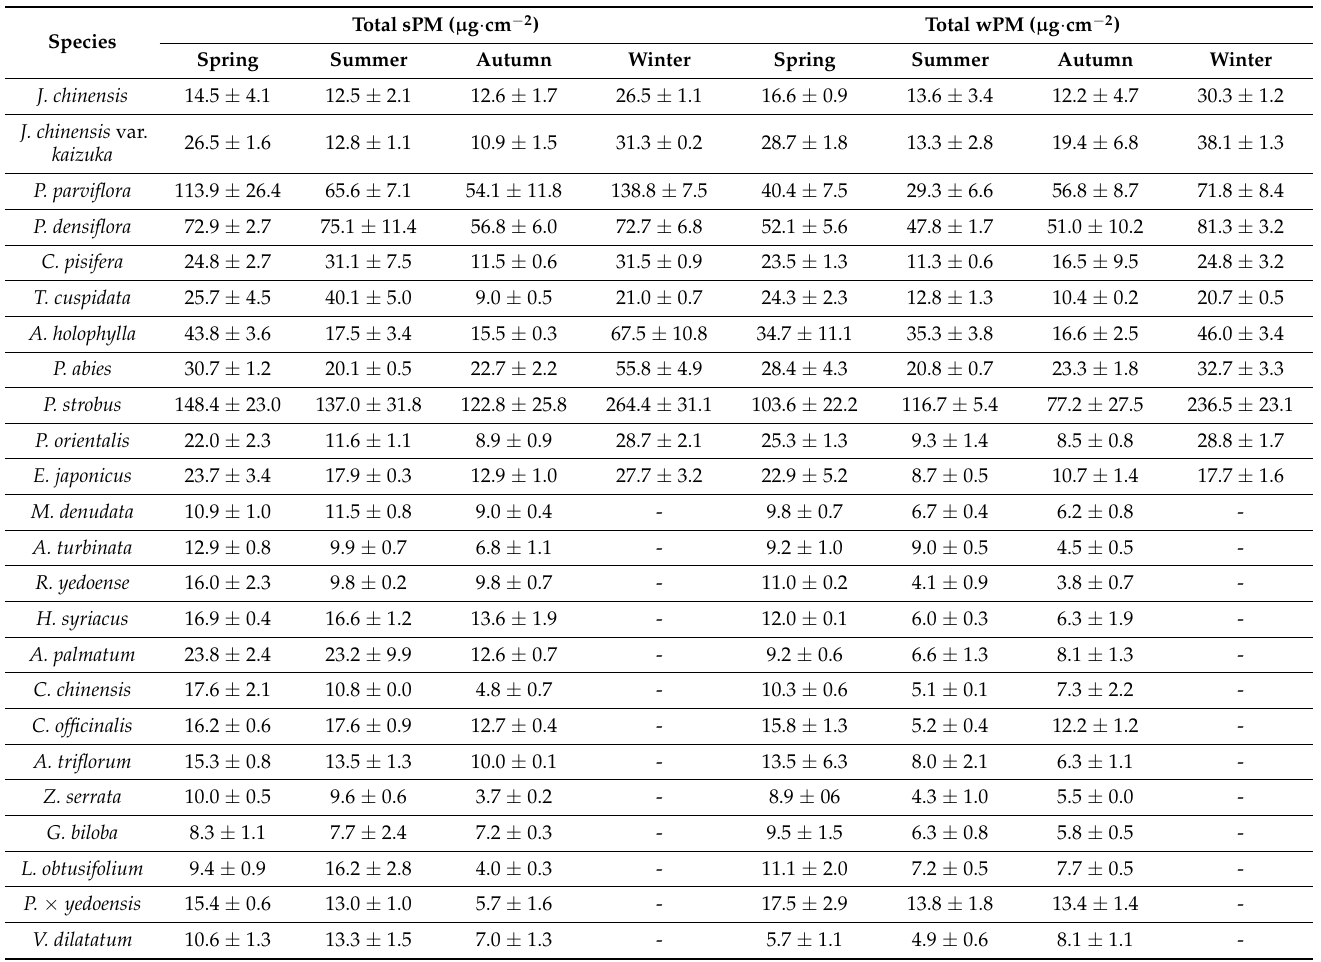
Table 2. The total PM accumulation on the leaf surface and the wax layer of 24 plant species in four seasons (spring, summer, autumn, and